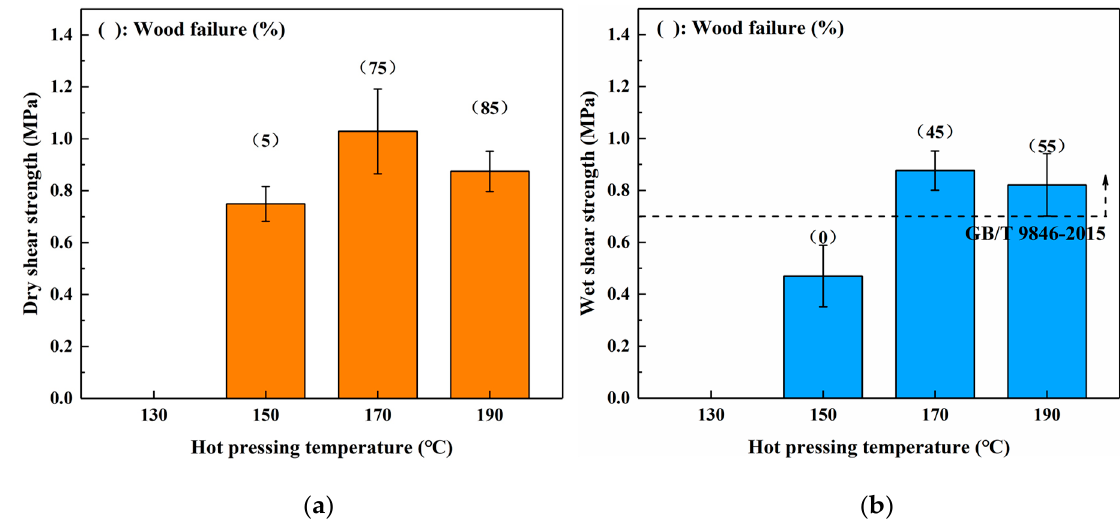
Figure 3. Effects of hot pressing temperature on the bond performance of plywood: ( a ) dry shear strength and ( b ) wet shear strength.